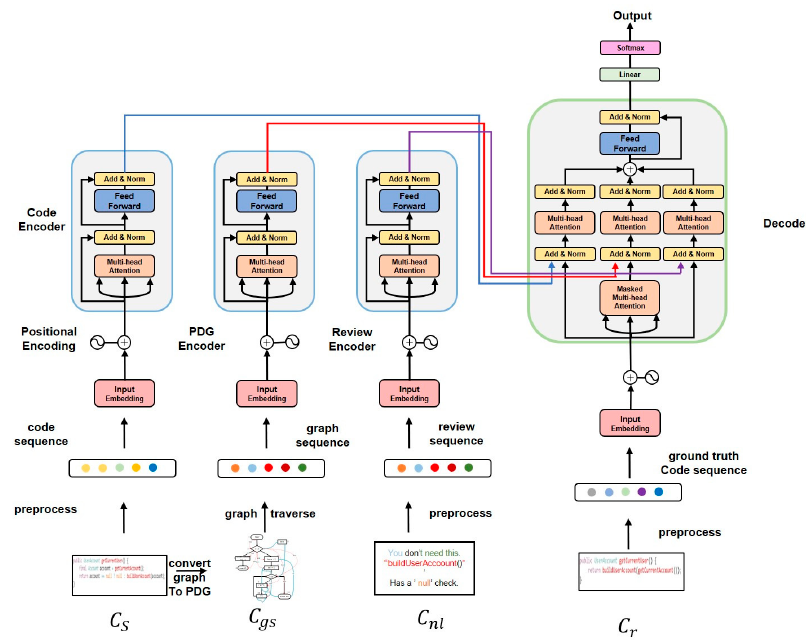
Figure 7. Task 2 corresponds to the model framework crBERT2.